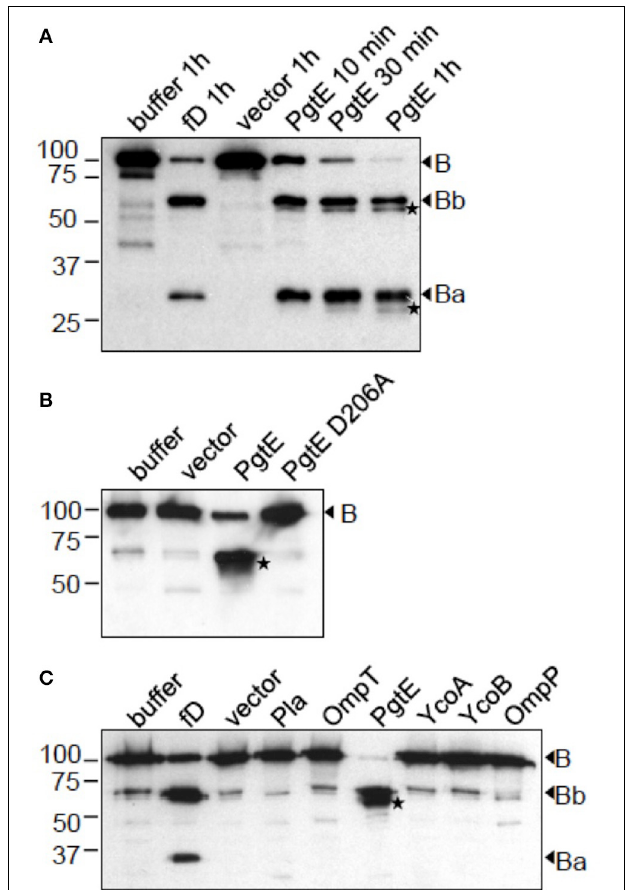
different omptin genes. The omptin proteins are indicated above the lanes. Control reactions of B incubated in buffer, with the empty vector plasmid-carrying strain or with factor D in the presence of C3 and Mg 2 + , are shown for comparison. (A) E. coli 83972 (cid:2) ompT bacteria expressing PgtE were incubated for 10min, 30min or 1h with B (16.7 μ g/ml). (B) E. coli XL1 bacteria expressing PgtE, D206A-mutant or the empty vector were incubated for 1h with B (33 μ g/ml). (C) E. coli 83972 (cid:2) ompT bacteria expressing omptin proteins or the empty vector were incubated for 1h with B (33 μ g/ml). Non-reduced (A) or reduced (B,C) supernatants were immunoblotted with a polyclonal anti-B antibody. Factor D-generated cleavage products Bb and Ba are indicated. PgtE-specific cleavage products are marked with asterices ( ∗ ). The assays were conducted at least twice with consistent